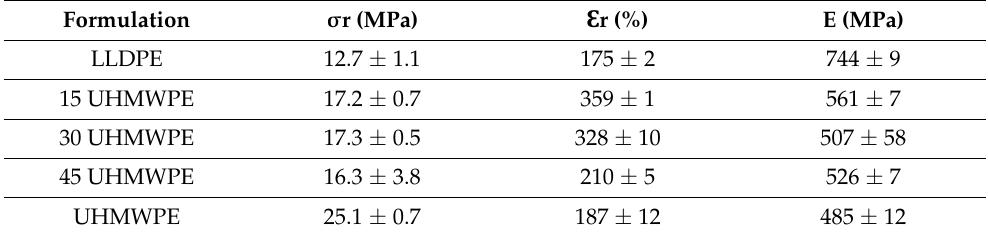
Figure 5. Typical stress – strain curve of LLDPE, UHMWPE, and the blends. Table 3. Tensile test data of LLDPE, UHMWPE, and blends.